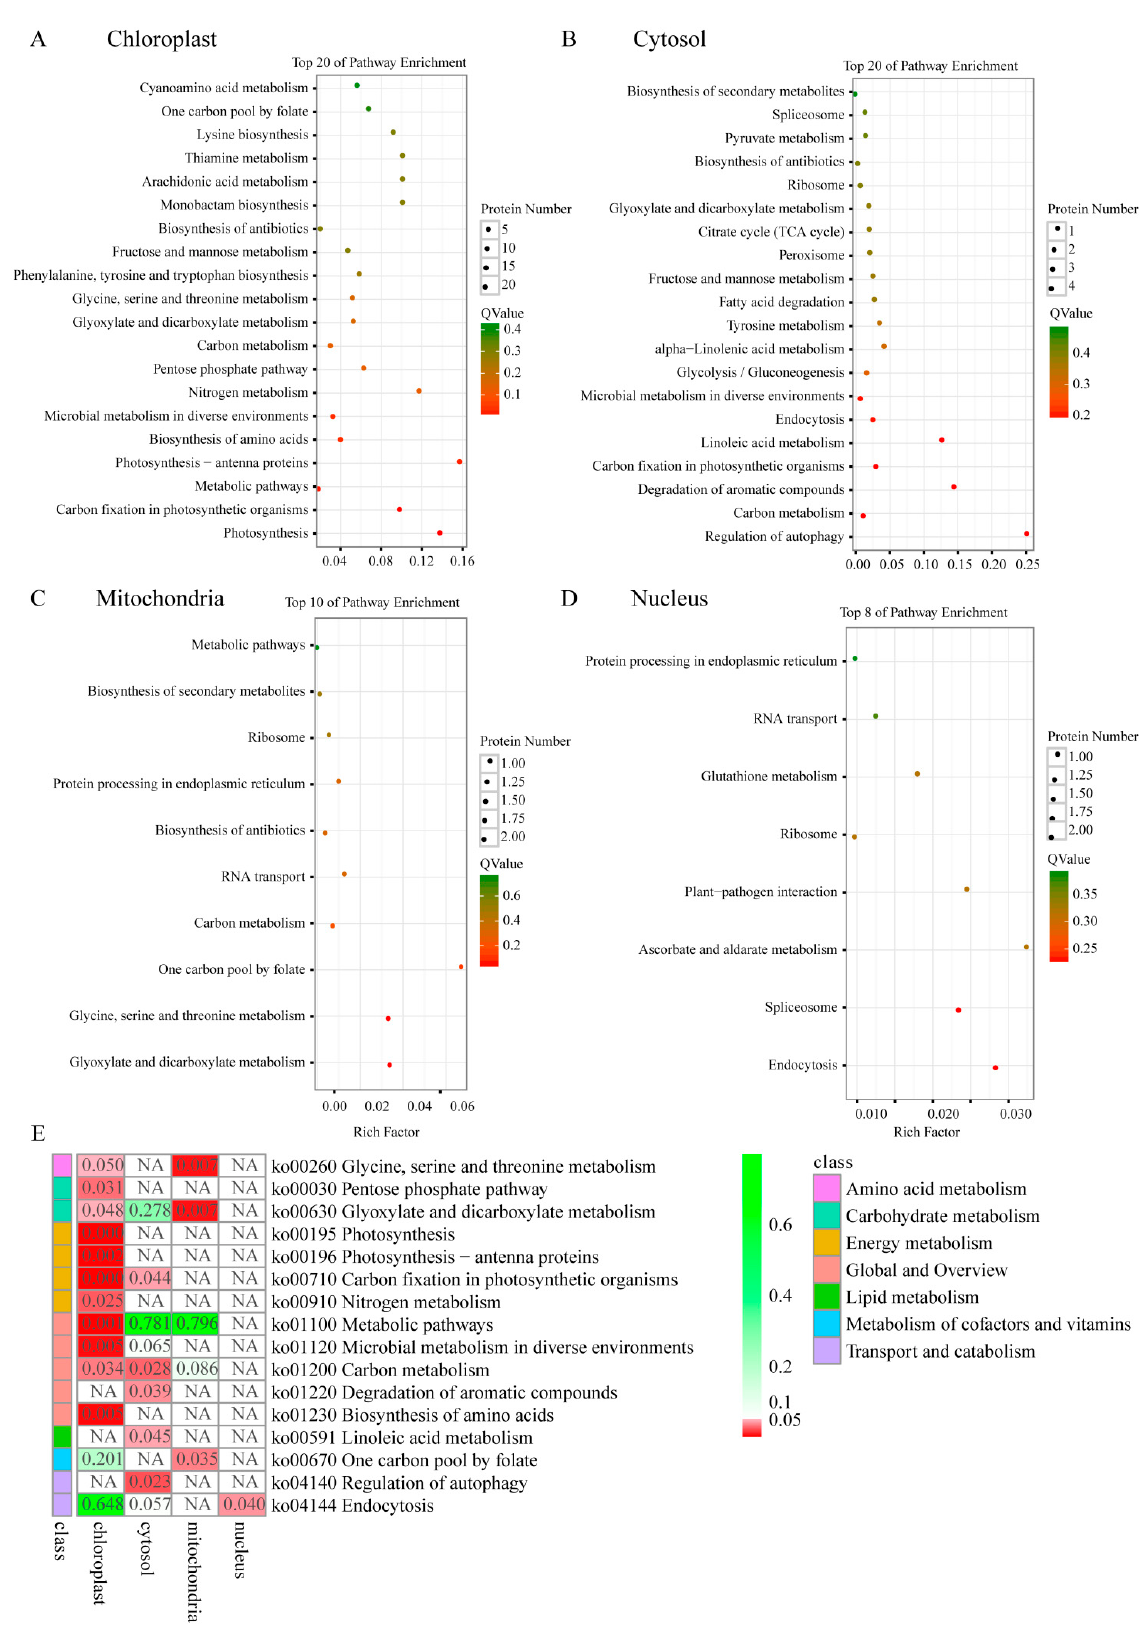
Figure 7. KEGG pathway enrichment of the specific di ff erential phosphoproteins (DPs) between the green and yellow sectors based on the chloroplasts ( A ), cytosol ( B ), mitochondria ( C ), and nucleus ( D ), the common sites from the G1 versus G2 comparison were excluded. ( E ), the heat map of the qv value.